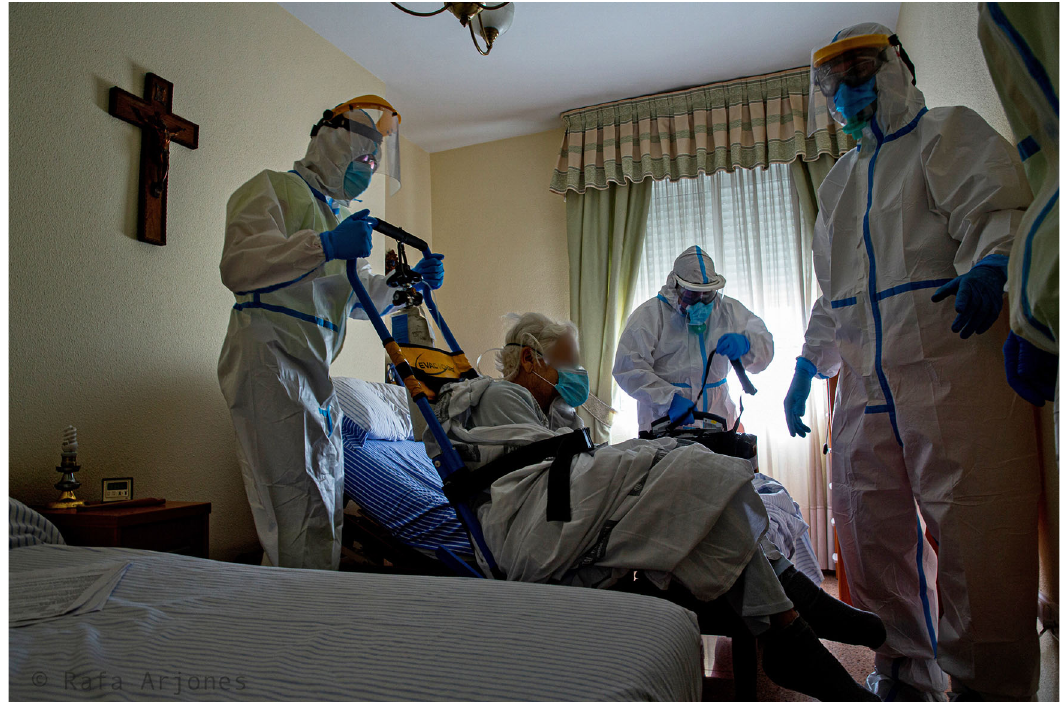
Figure11.Atthattime,healthmeasuresweregreatlyincreased. Inthepictureyoucanseehowasmallroomwas occupied by several people in order to clean and keep the sanitary situation under control. In the process, the social spacebecomes(symbolically)analternative “ healthcentre ” .Thisfigurehasbeenreproducedwithkindpermissionof the